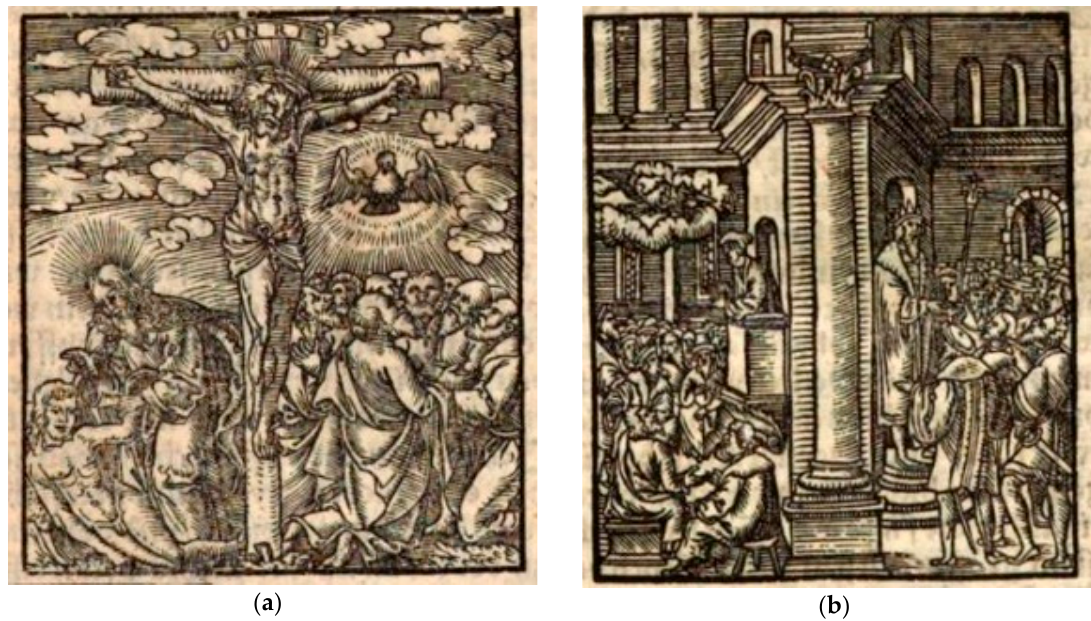
Figure 5. Woodcuts recurring in books published by vom Berg and Neuber. ( a ) Holy Trinity (Creation of Adam, Crucifix, and Pentecost) [S 32], in (Luther 1544b, fol. CXLIV) (Munich, Bayerische Staatsbibliothek, 2 Hom. 277, urn:nbn:de:bvb:12-bsb10144039-2; NoC-NC/1.0); ( b ) Two Kingdoms [S 69], in (Luther 1544b, part 3, fol. LXII) (Munich, Bayerische Staatsbibliothek, 2 Hom. 277, urn:nbn:de:bvb:12-bsb10144039-2; NoC-NC/1.0).